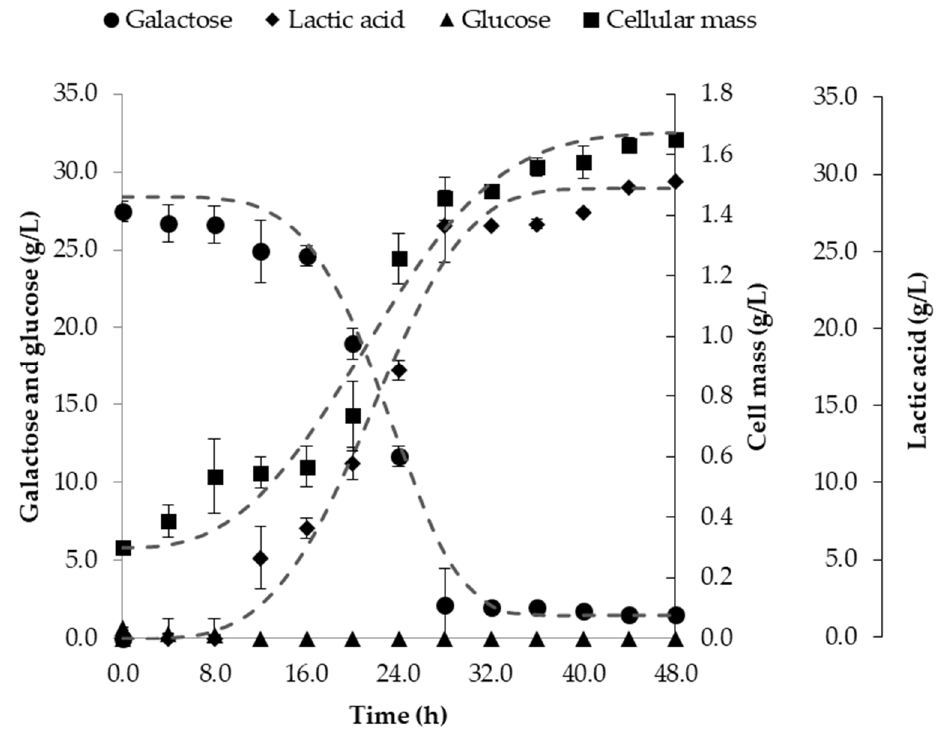
Figure 3. Batch fermentation kinetics of lactic acid by acclimatized Lactobacillus pentosus from detoxified Kappaphycus alvarezii hydrolysates in 2-L bioreactor with a 1-L working volume at pH 6, 37 °C, and 150 rpm.